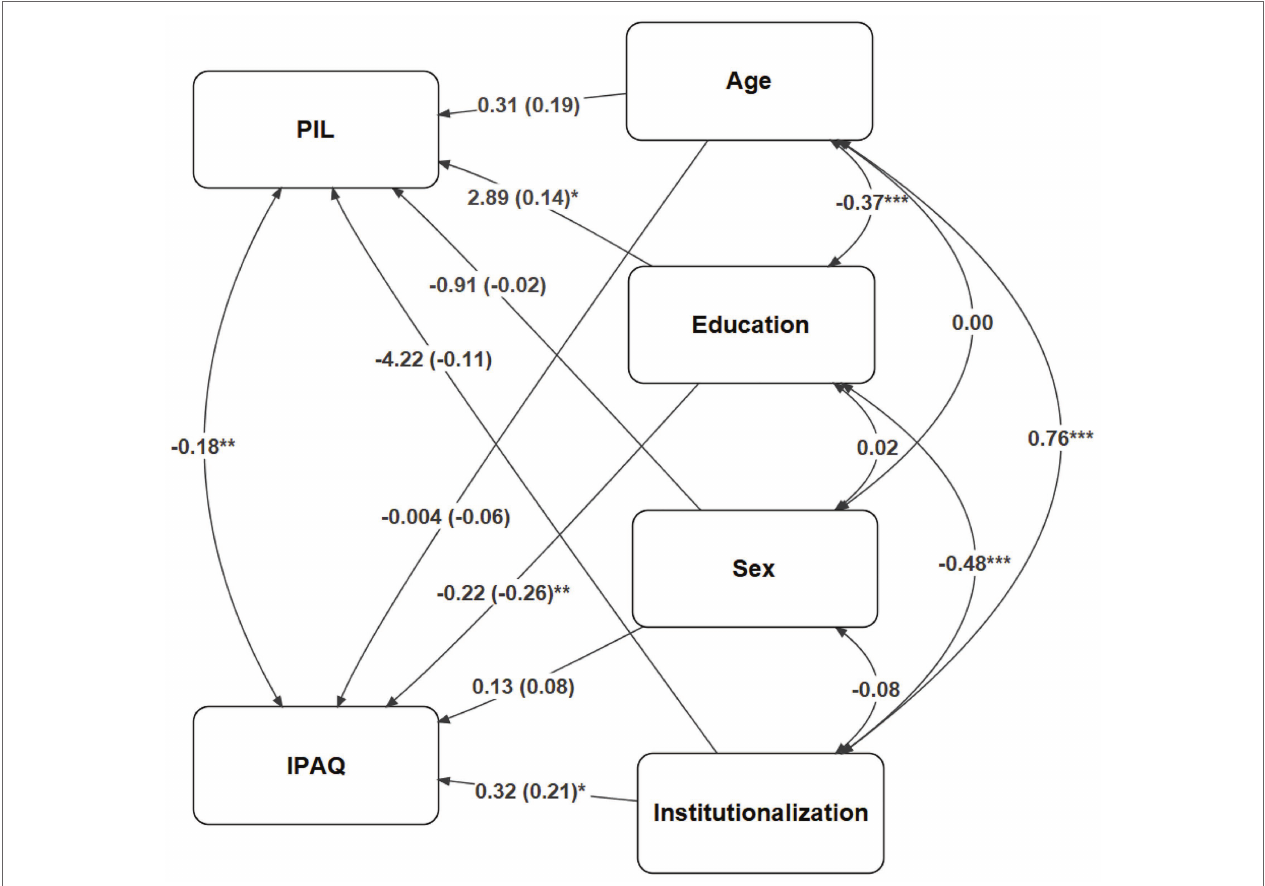
FIGURE 1 | Structural equations model with the sociodemographic variables institutionalisation, gender (sex), education, and age as predictors of physical activity (IPAQ) and life satisfaction (PIL). Institutionalisation: 0 = Non-institutionalised, 1 = Institutionalised. Sex: 0 = Male, 1 = Female. Education: 1 = Without Studies, 2 = Primary, 3 = Secondary, 4 = University. After taking into account the correlations between predictors, institutionalisation remains a predictor of physical activity, and education remains a predictor of both physical activity and life satisfaction. Values for one-sided arrows: natural estimates (standardised values). Values for two- sided arrows: standardised correlation indices. * p < 0.05; ** p < 0.01; *** p <